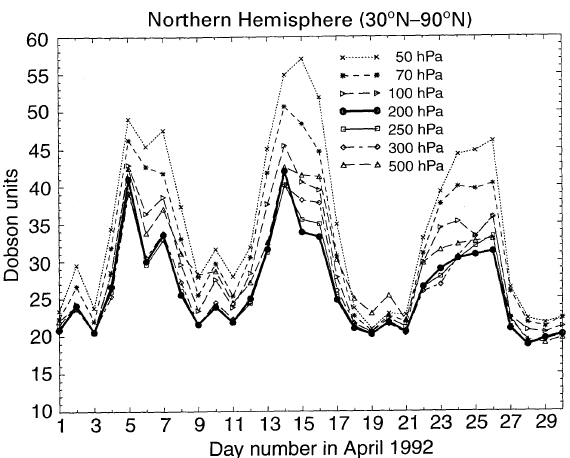
Fig. 6. As in Fig. 5 but only for the NH region (30 °— 90 ° N)